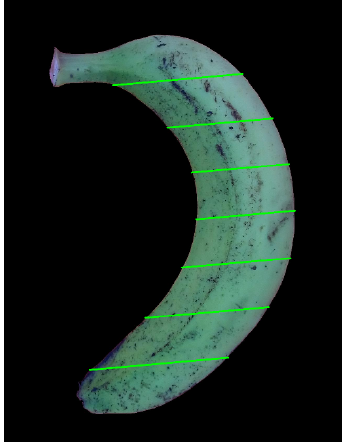
Figure 27. An example that our system can deal with bending fruits/vegetables.